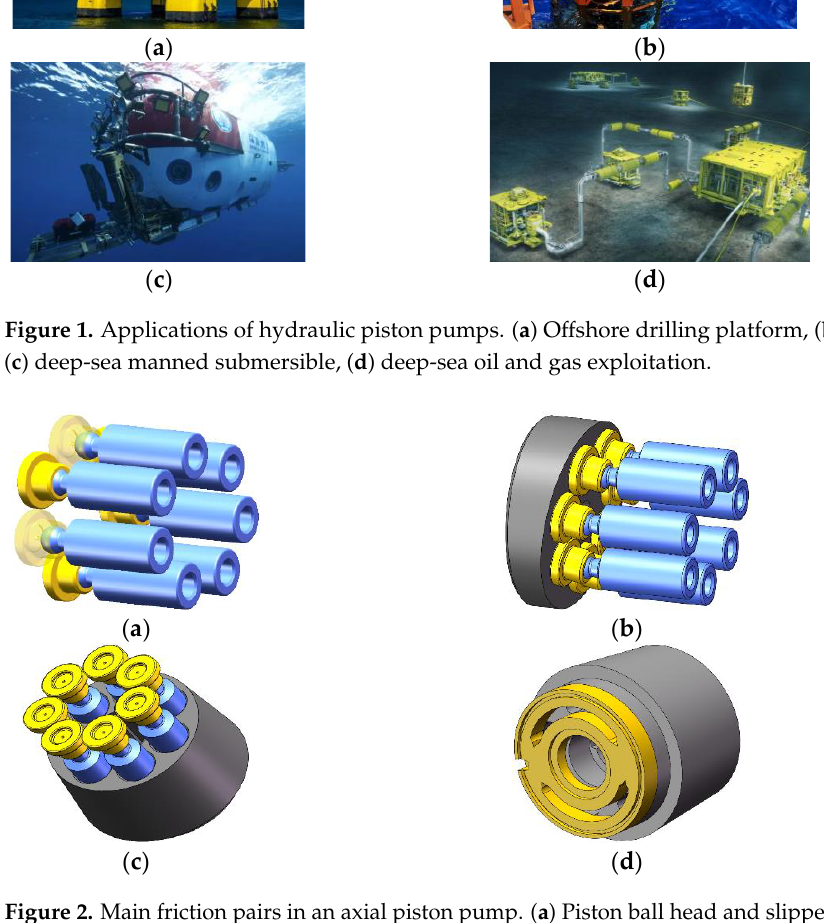
Figure 2. Main friction pairs in an axial piston pump. ( a ) Piston ball head and slipper, ( b ) slipper and swash plate, ( c ) piston and its hole, ( d ) cylinder and valve